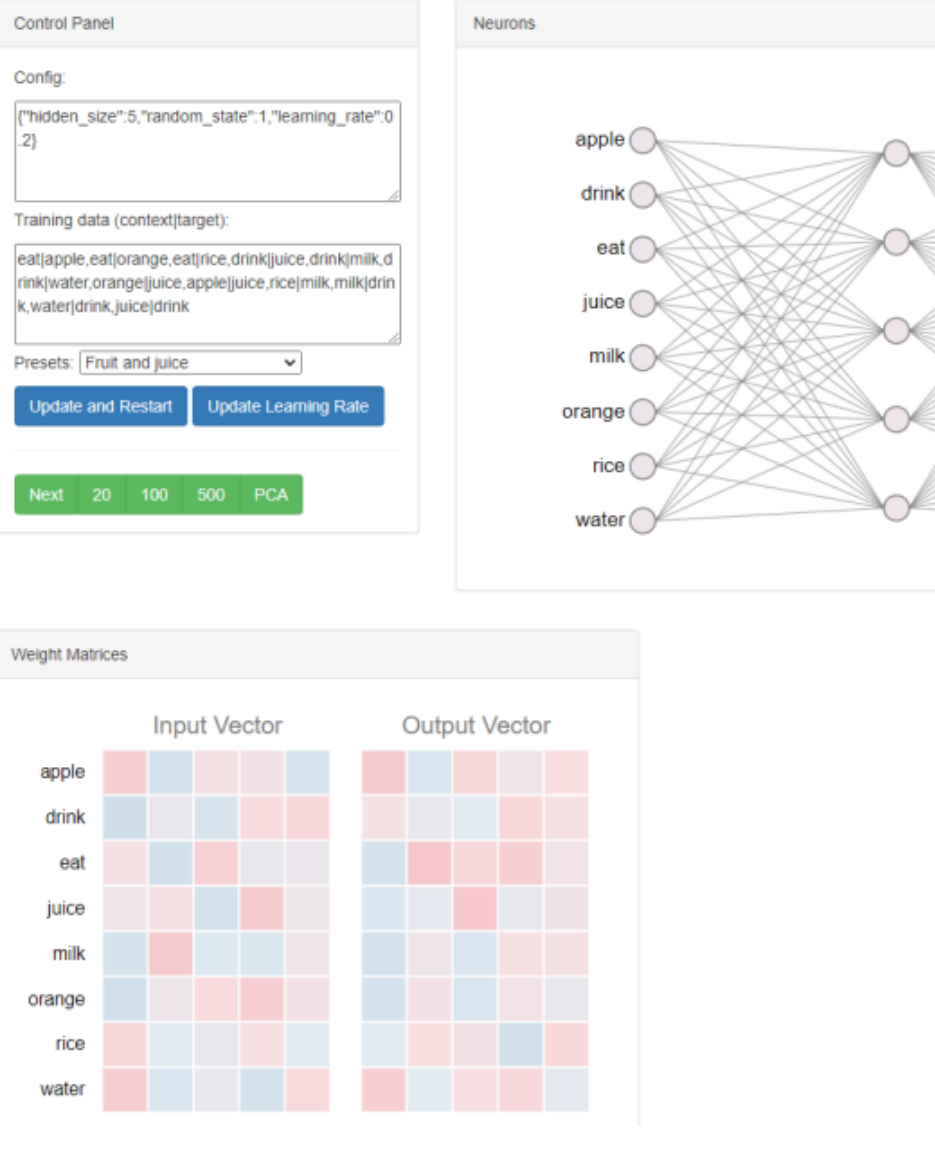
Figure 2. Illustration of the web tool “wevi”.